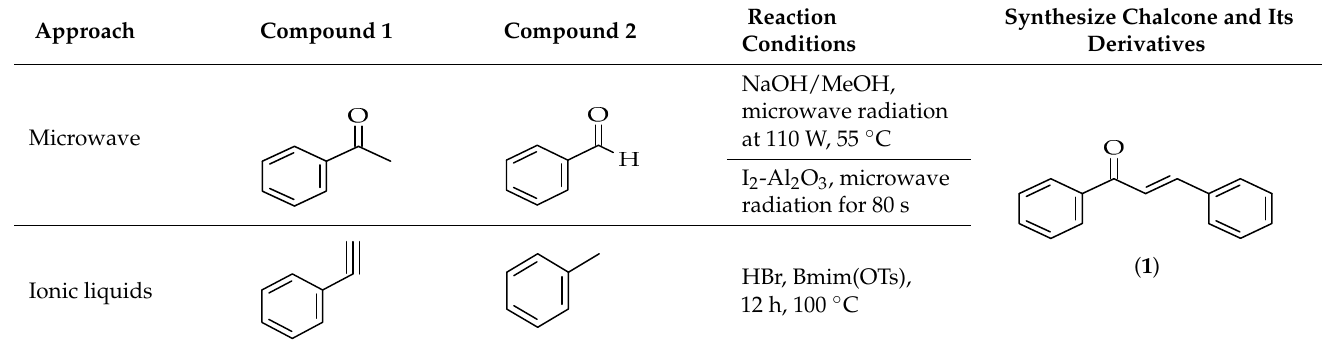
Table 1. Synthesis of some chalcone and chalcone derivatives [7–9].